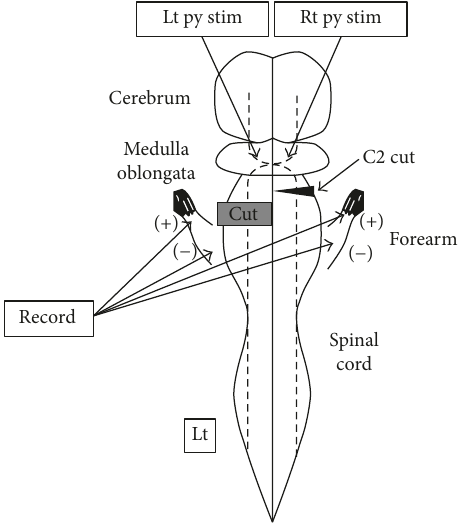
Figure 2: Left and right pyramidal tracts and measurement method. The left and right pyramids were stimulated separately, and CMAPs of both forelimbs were recorded. Py: pyramid; stim: stimulation; Lt: left; Rt: right; broken line: pyramidal tracts (plus sign in the medulla